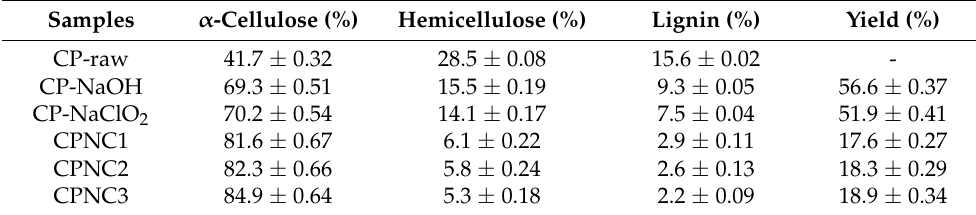
Figure 2. Images of ( a ) TEM, ( b ) EDX, ( c ) width size distribution, and ( d ) length size distribution for CPNC3 sample. Table 1. Chemical composition and yield of different fibres.